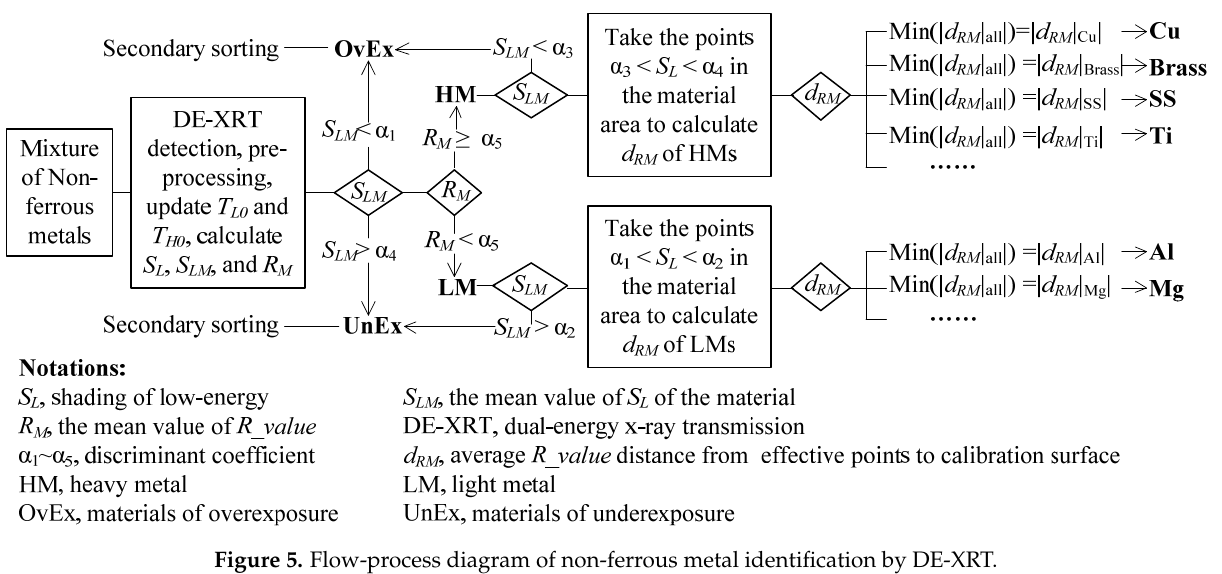
Figure 5. Flow-process diagram of non-ferrous metal identification by DE-XRT.